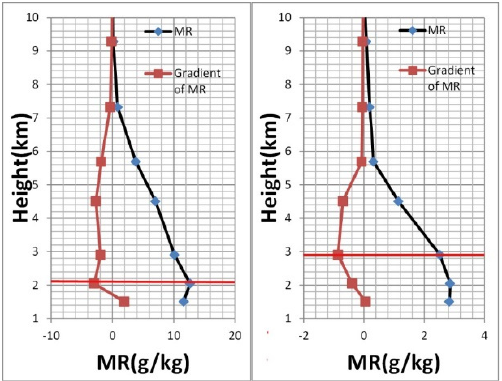
Figure 3. Profile of the MR and vertical gradient of the MR (in red) retrieved from MODIS atmospheric profile data for Jiuquan and Zhangye radiosonde stations on 10 August